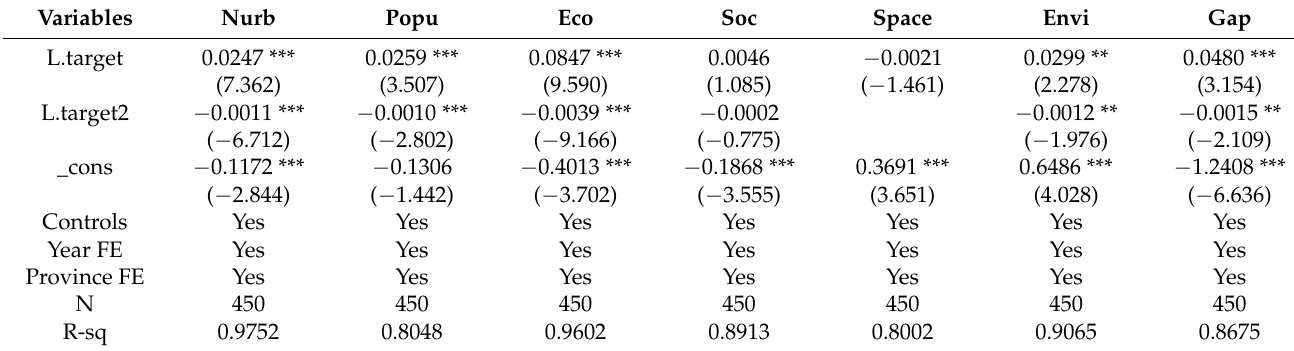
Table 10. Robustness